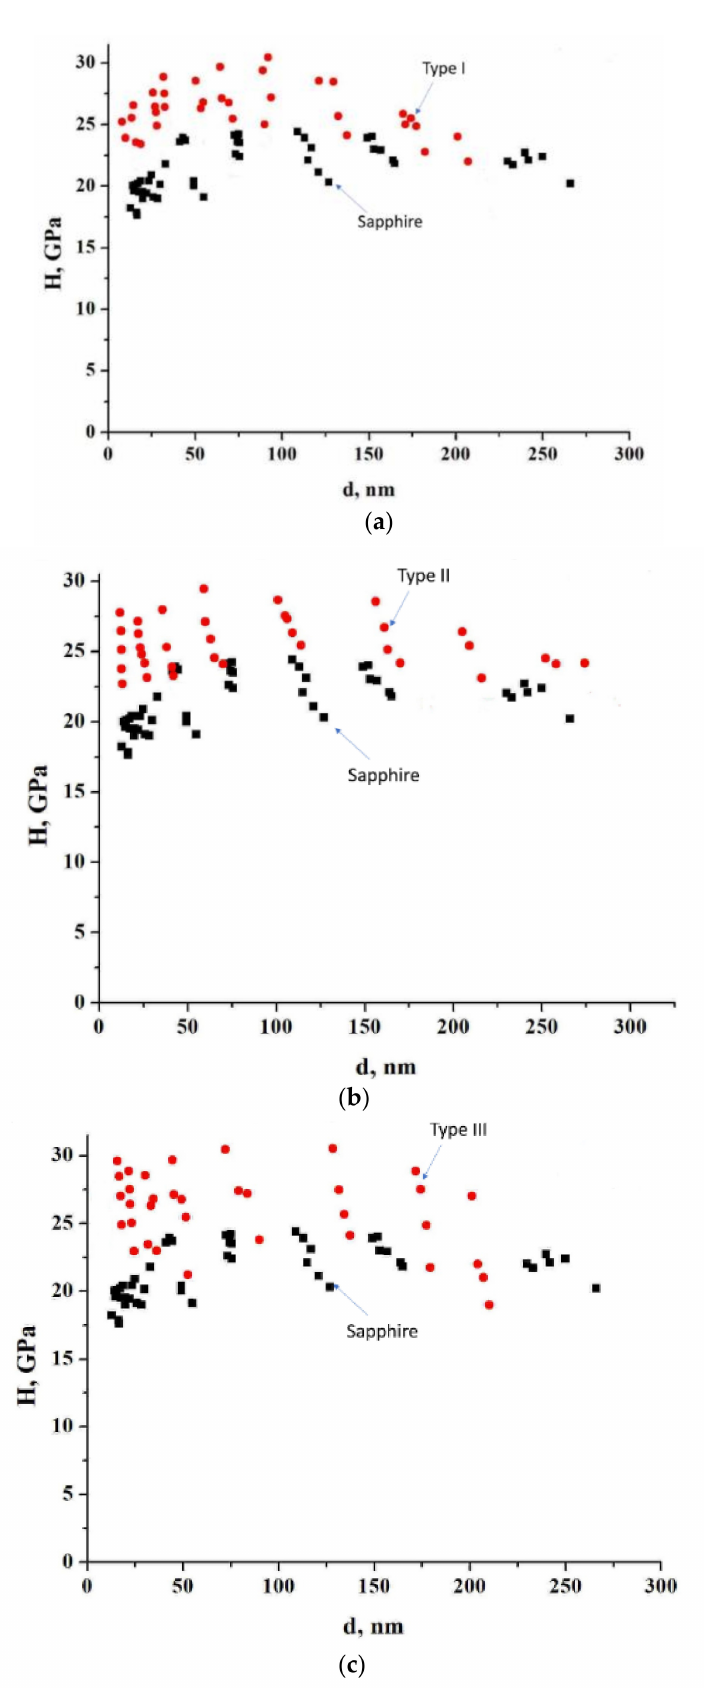
Figure 6. Comparison of the dependence of microhardness on the depth of the indentation of the surface of sapphire and samples of types I ( a ), II ( b ), and III ( c